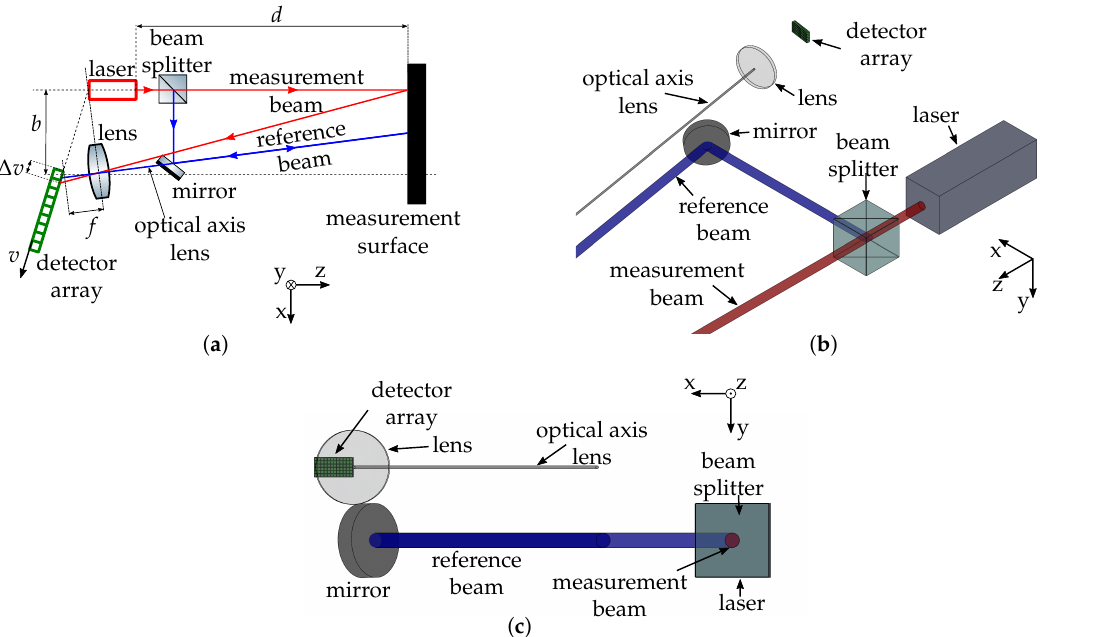
Figure 2. Schematic of a setup able to compensate for errors due to laser beam dithering, air refractive gradients and optomechanical thermal effects. ( a ) Schematic top view. ( b ) Isometric CAD view. ( c ) Frontal CAD view.